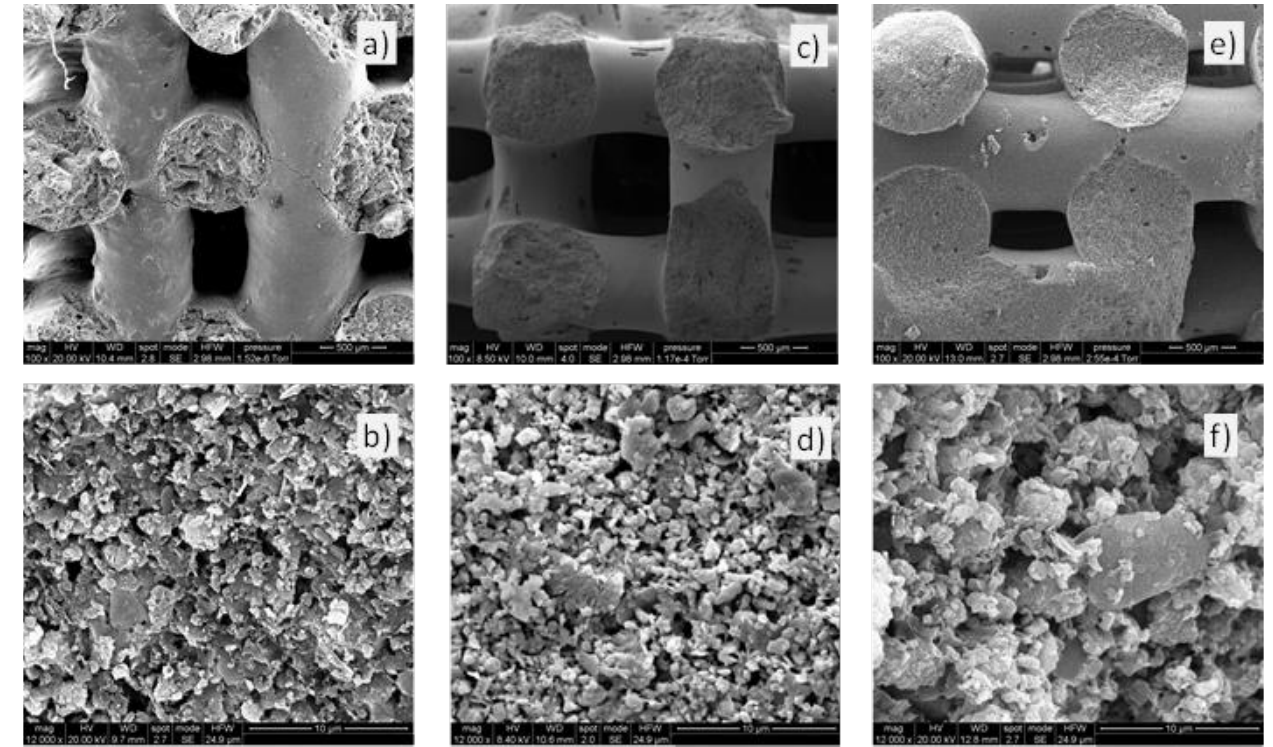
Figure 1. SEM images of the cross-section of the struts of acid-treated GP ( a , b ), GP – Z(37) ( c , d ) (adapted from [32]) and GP – Z(60) ( e , f ) monoliths.